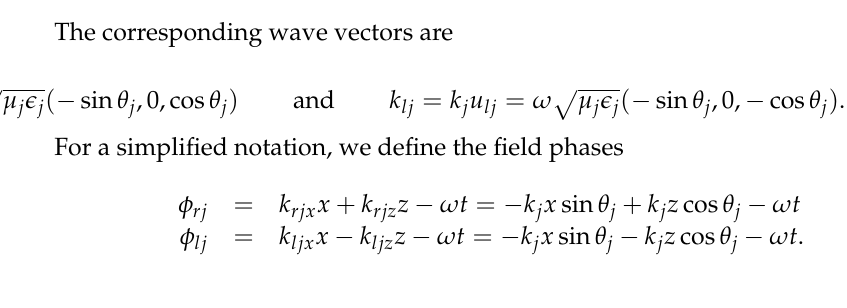
Figure 1. Right and left moving electromagnetic waves in the superlattice